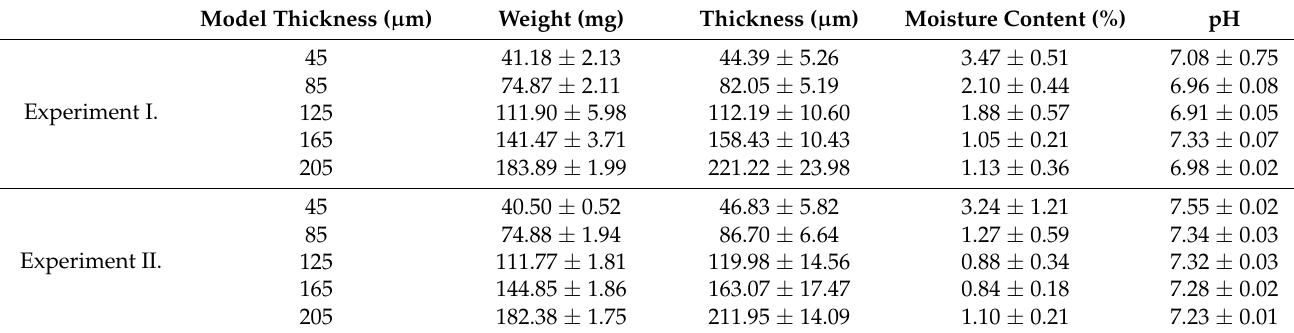
Table 3. Properties of ODFs from experiments I. and